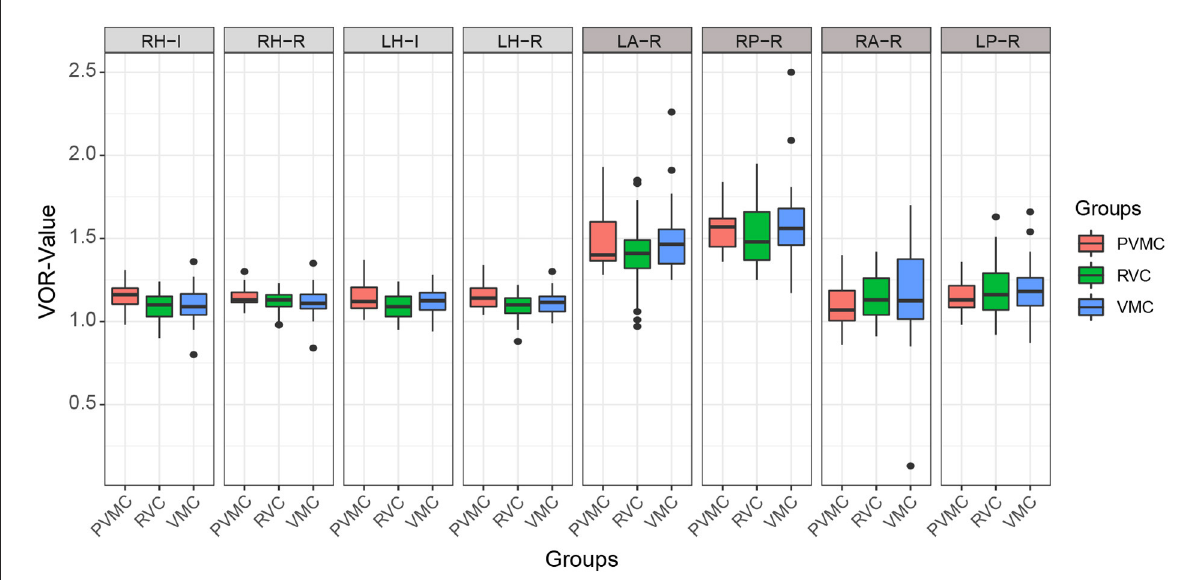
FIGURE2 Characteristics of vHIT results. Results of instantaneous and regression VOR gain of each semicircular canals. The center line of the box represents the average VOR gain. RH-I, Instantaneous VOR gains in the right horizontal semi-circular canal; RH-R, Regression VOR gains in the right horizontal semi-circular canal; LH-I, Instantaneous VOR gains in the left horizontal semi-circular canal; LH-R, Regression VOR gains in the left horizontal semi-circular canal; LA-R, Regression VOR gains in the left anterior semi-circular canal; RP-R, Regression VOR gains in the right posterior semi-circular canal; RA-R, Regression VOR gains in the right anterior semi-circular canal; LP-R, Regression VOR gains in the left posterior semi-circular